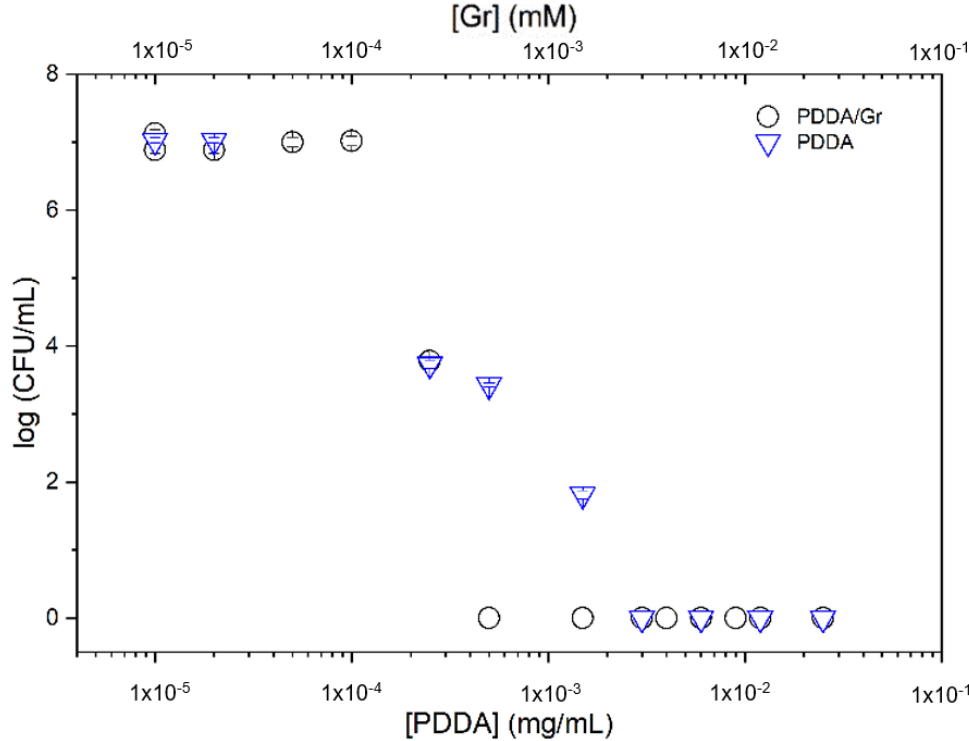
Figure 10. Cell viability of Pseudomonas aeruginosa PA14 (10 7 CFU/mL) after interacting for 1 h with poly (diallyl dimethyl ammonium chloride) (PDDA) solutions (blue inverted triangles) or gramicidin nanoparticles Gr NPs/PDDA (black hollow circles) over a range of Gr and/or PDDA concentrations. The Gr NPs/PDDA combination implements the activity of both antimicrobial agents.